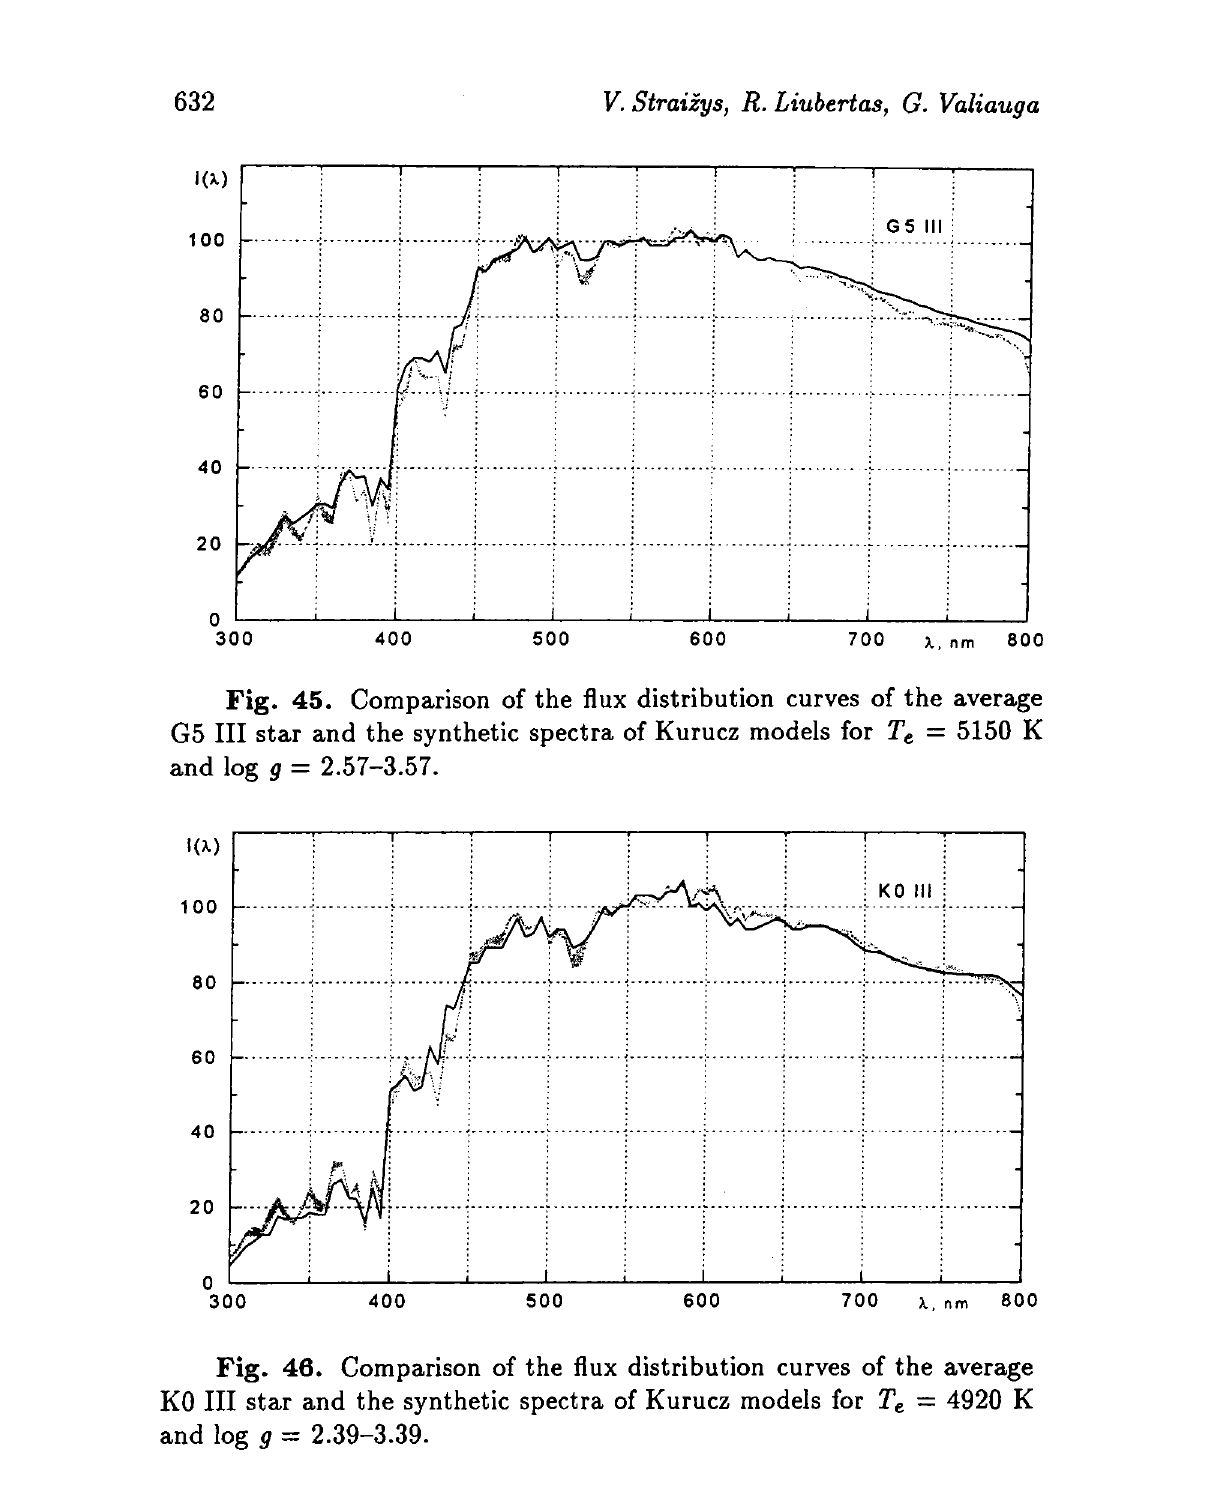
Fig. 46. Comparison of the flux distribution curves of the average KO III star and the synthetic spectra of Kurucz models for T e — 4920 K and log g =